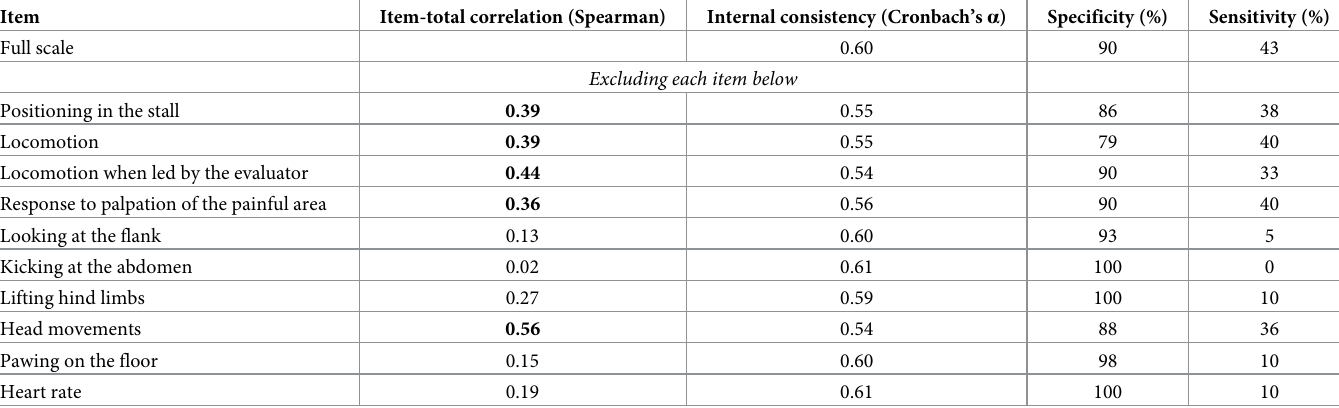
Table 7. Item-total correlation and internal consistency, specificity, and sensitivity for the Unesp-Botucatu horse acute pain scale